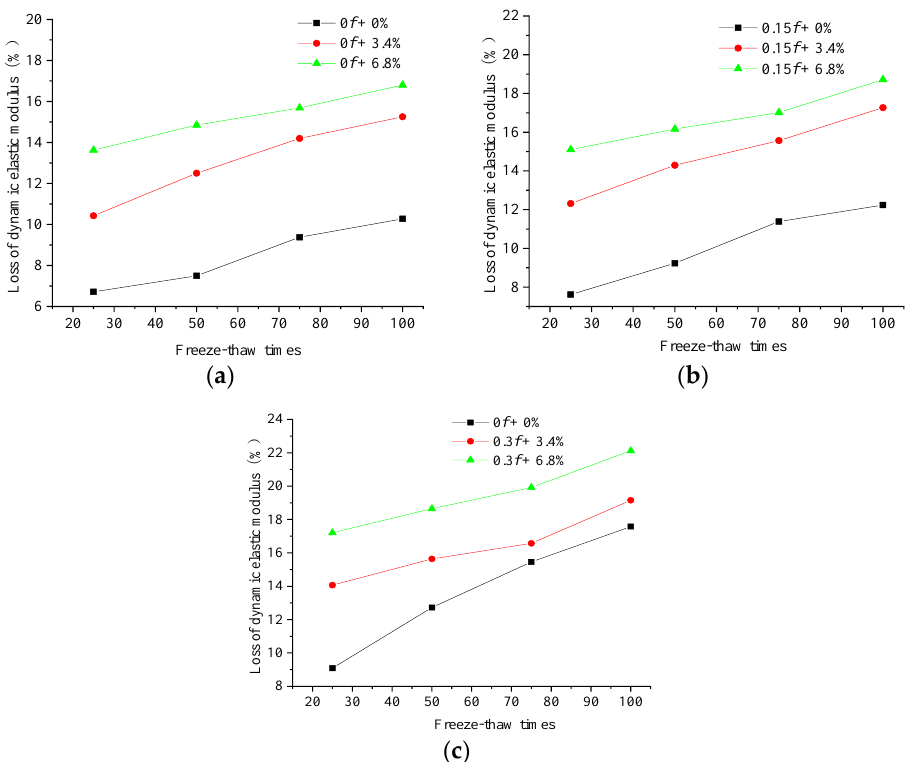
Figure 4. Dynamic elastic moduli of concrete samples in freshwater and two salt solutions. ( a ) With- out an initial load. ( b ) With an initial load of 0.15 f . ( c ) With an initial load of 0.3 f .